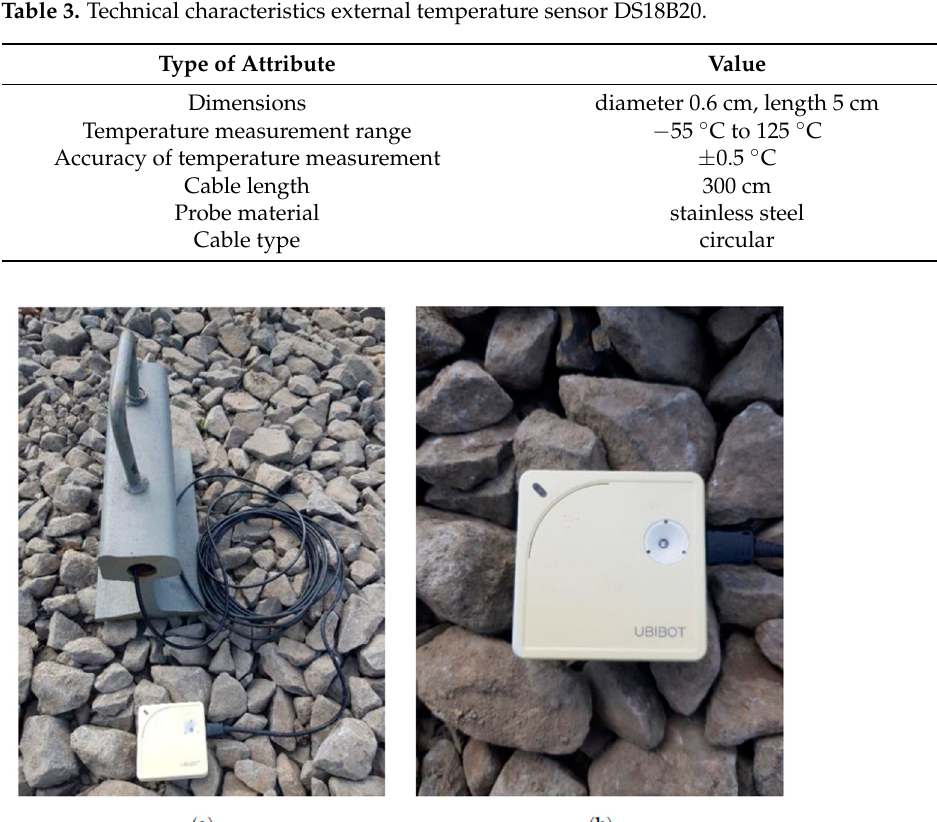
Figure 1. Measuring station T szyn WS1 WIFI with rail type S49 (49E1) (own photograph): ( a ) electronic thermometer with probe inside crown of the rail; ( b ) wireless data logger UbiBot WS1 WIFI. The rail had a hole in the crown of the rail with a diameter of ϕ 25.0 mm and a depth of 228 mm (Figure